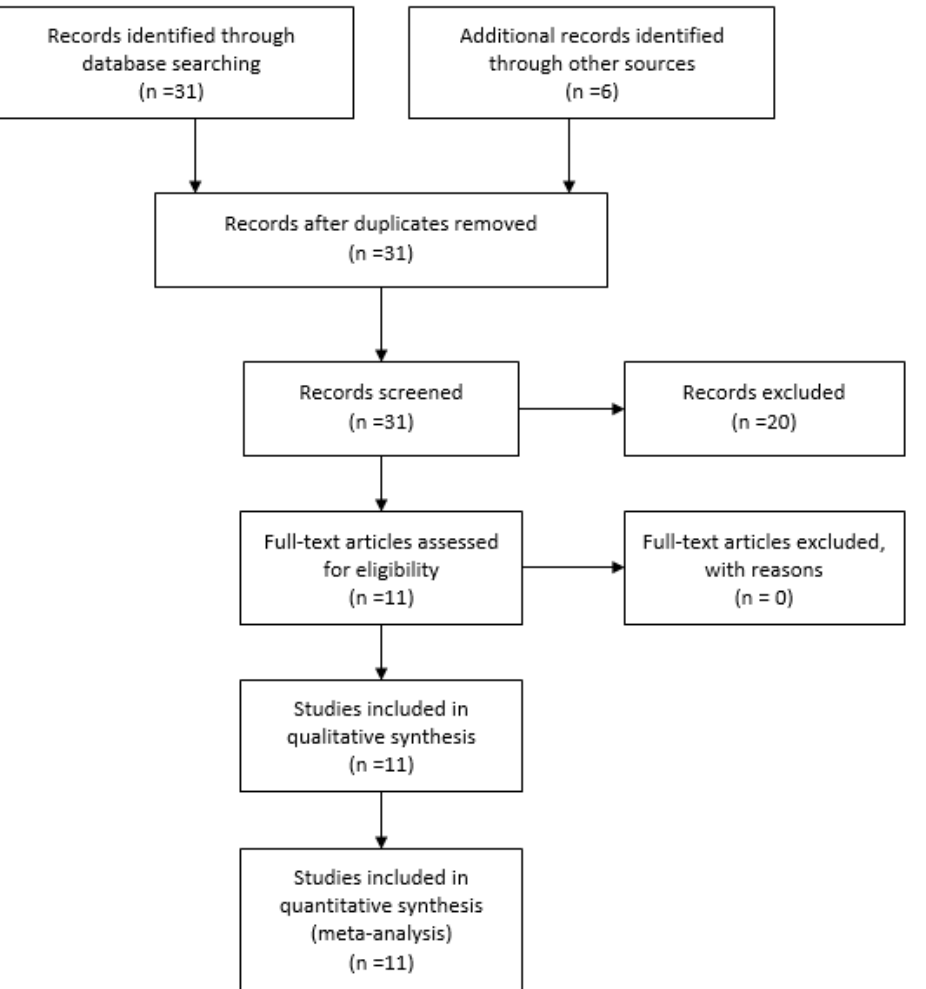
Figure 1. PRISMA flow diagram showing the literature search on itch in wounds.